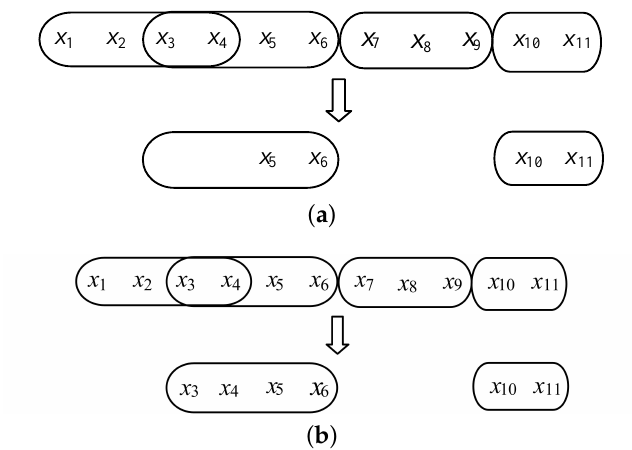
Figure 1. Coefficients with overlapping group structure.